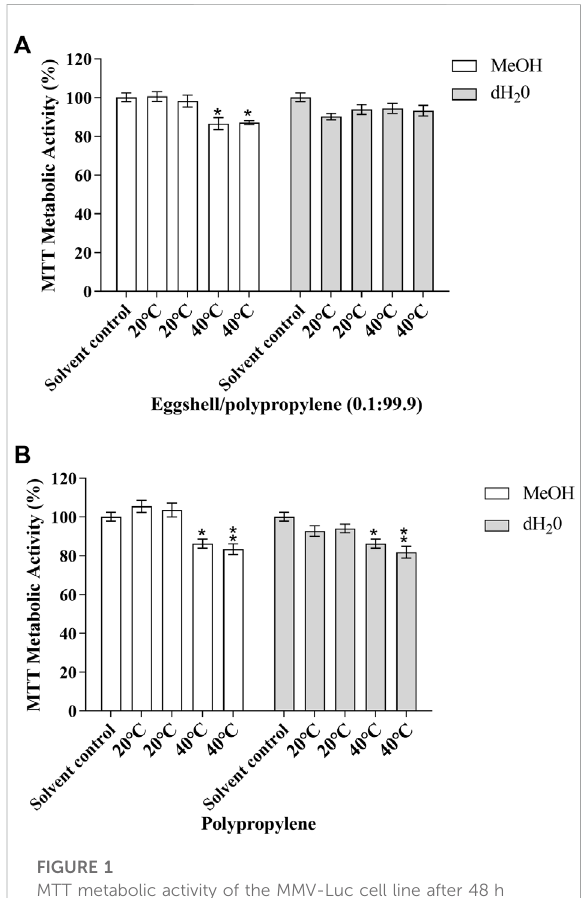
FIGURE 1 MTT metabolic activity of the MMV-Luc cell line after 48 h exposure to (A) eggshell/polypropylene (0.1:99.9) and (B) polypropyleneandsolventcontrol(MeOH0.5%).Dataisexpressed as percentage of solvent control (MeOH 0.5% v:v); mean ± SEM, n = 3. p ≤ 0.05 (*) and p ≤ 0.01 (**).